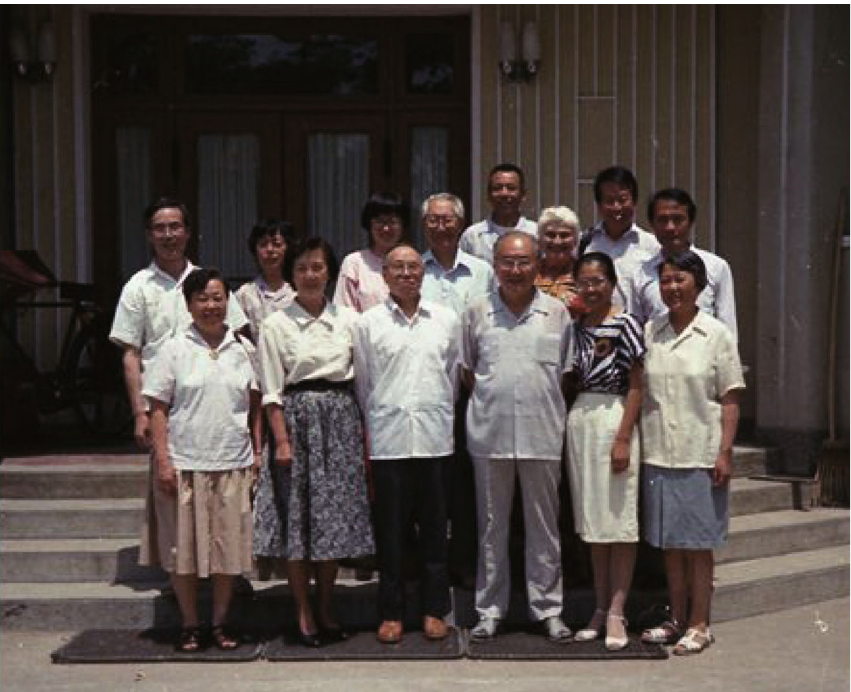
Figure 5. Jiao Shao ( fi rst row, third from right) at the doctoral dissertation defense of Yanjie Su ( fi rst row, second from